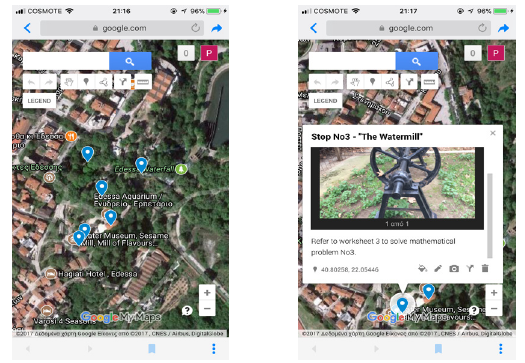
Fig. 1. Map with points of the path in Google Maps